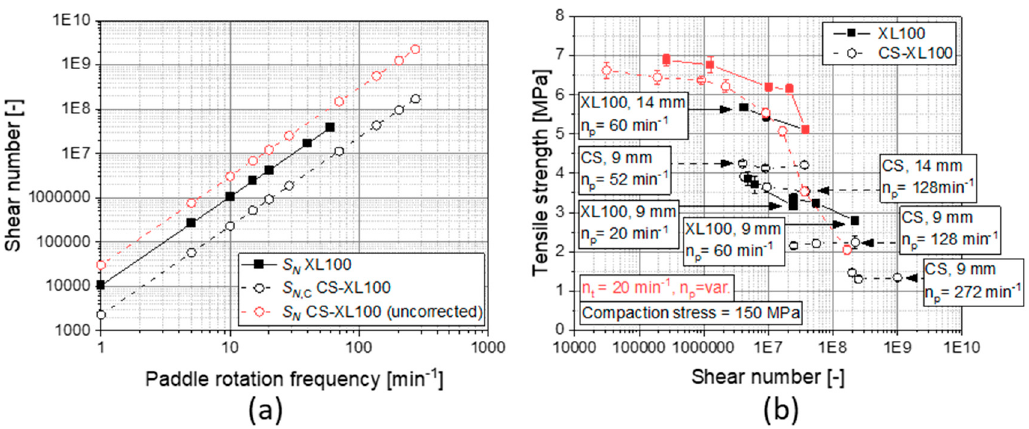
Figure 9. Comparison of shear numbers for an XL100 and uncorrected and corrected shear number for the CS simulating the XL100 at a turret rotation frequency of 20 min − 1 and 9 mm punches ( a ) as well as the effect of shear number on the tensile strength, elucidating the influence of turret rotation frequency, paddle rotation frequency, and punch size on this correlation on an XL 100 and on a CS simulating the XL100 ( b , n = 10). All data and experiments for MCC admixed with 1 wt.-% of MgSt.